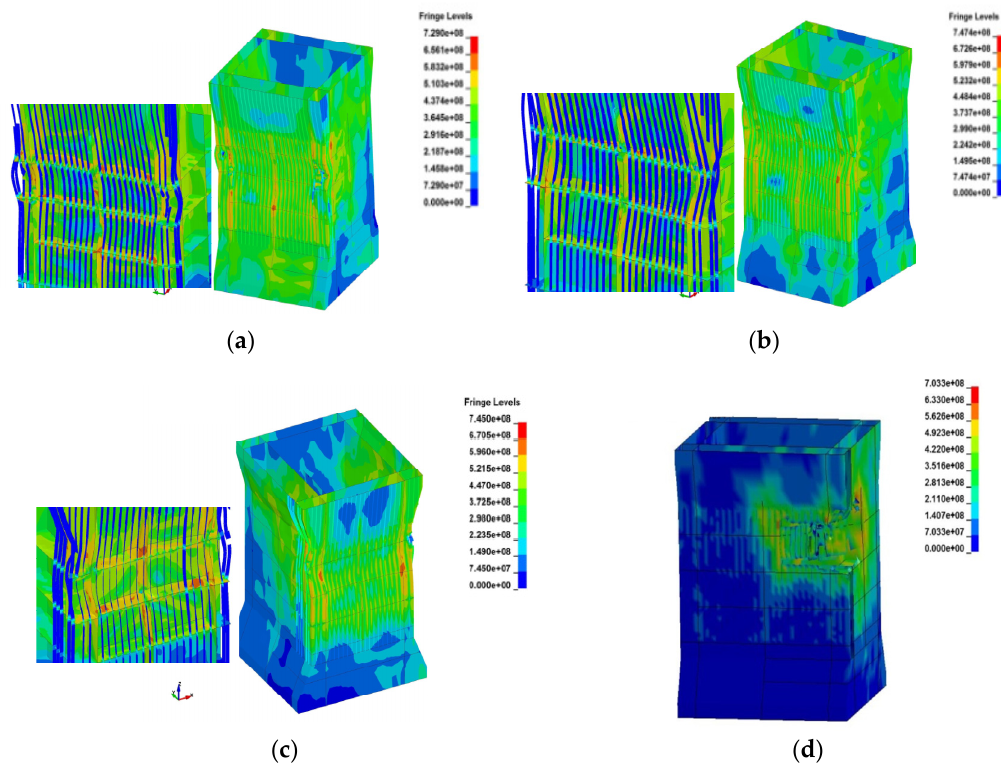
Figure 12. The stress nephograms in different collision areas. ( a ) S-SP1 stress nephogram. ( b ) S-SP4 stress nephogram. ( c ) S-SP5 stress nephogram. ( d ) S-SP6 stress nephogram.